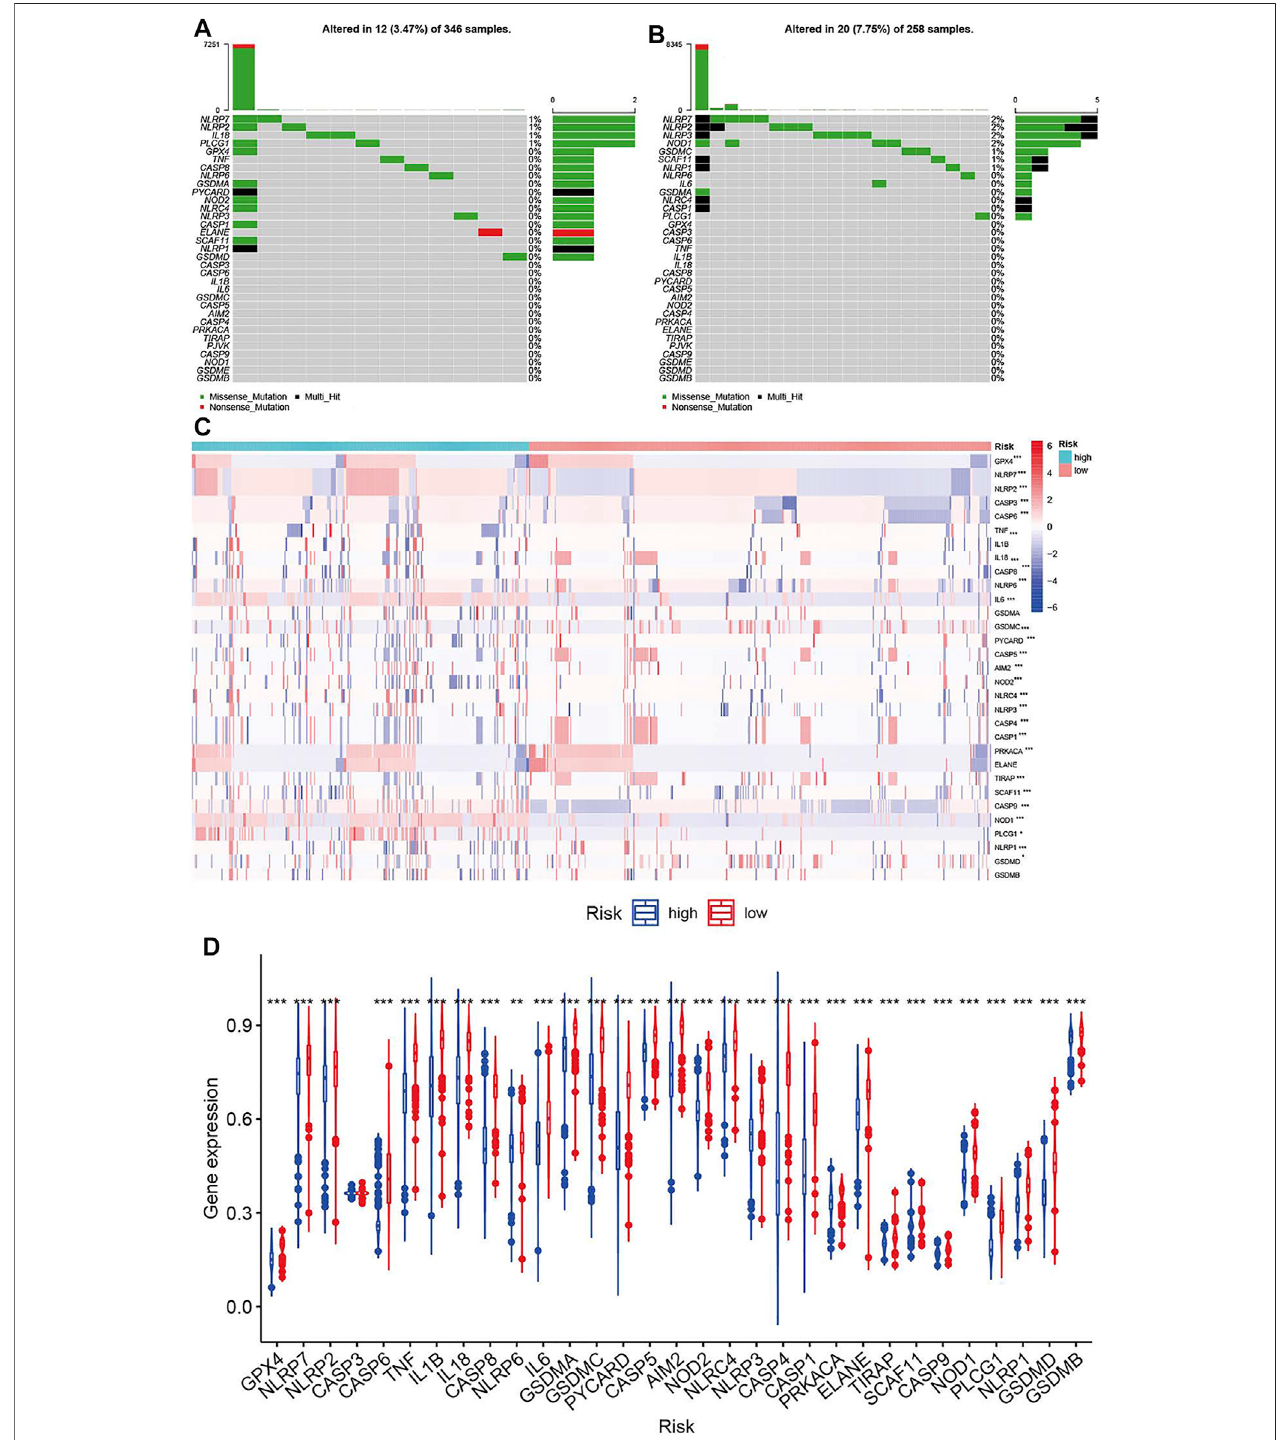
FIGURE 7 | Molecular alterations of pyroptosis-related genes in TCGA dataset. (A) The mutations frequencies in low-risk group. (B) The mutations frequencies in high-risk group. (C) Somatic copy number alteration based on risk groups. (D) DNA methylation expression based on risk groups.